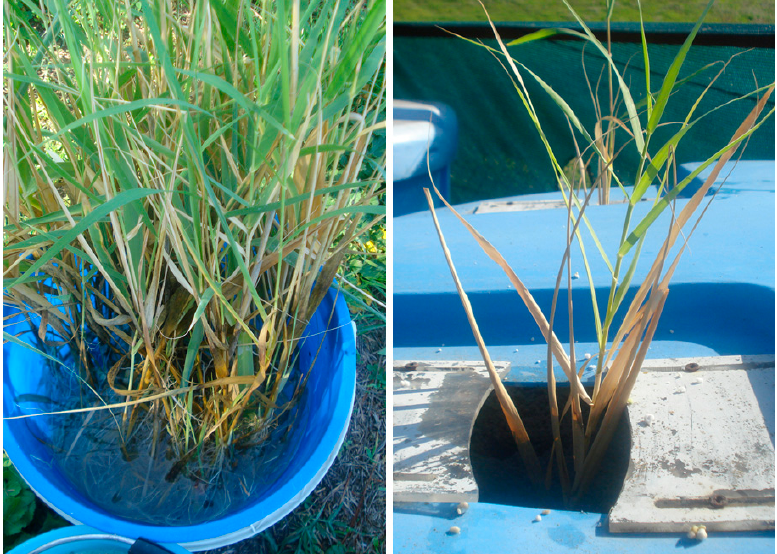
Figure 2. Transplant of the rooted cuttings inside the mesocosm.